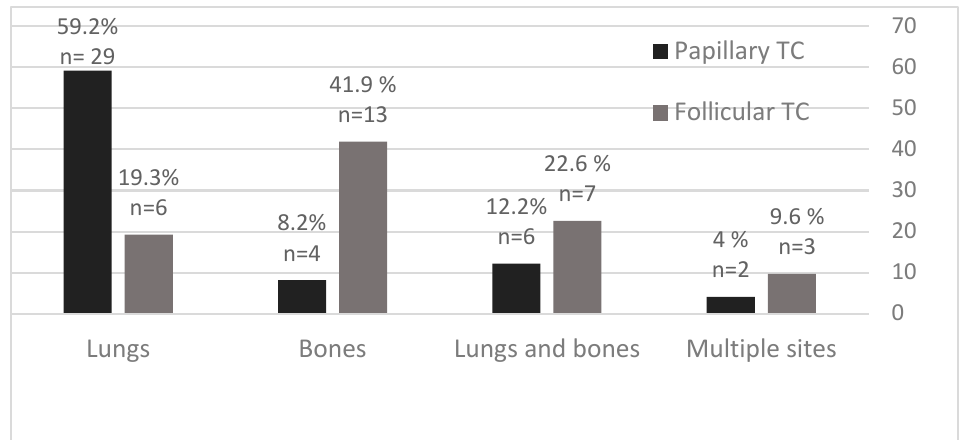
Figure 2. Cumulative events for new distant metastases of PTC and FTC.